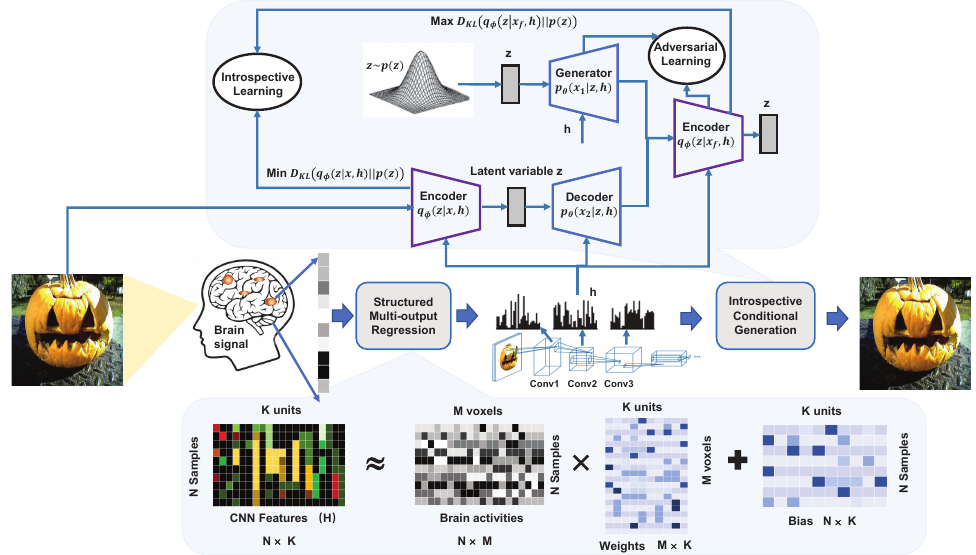
Figure 2. Structured deep generative neural decoding model